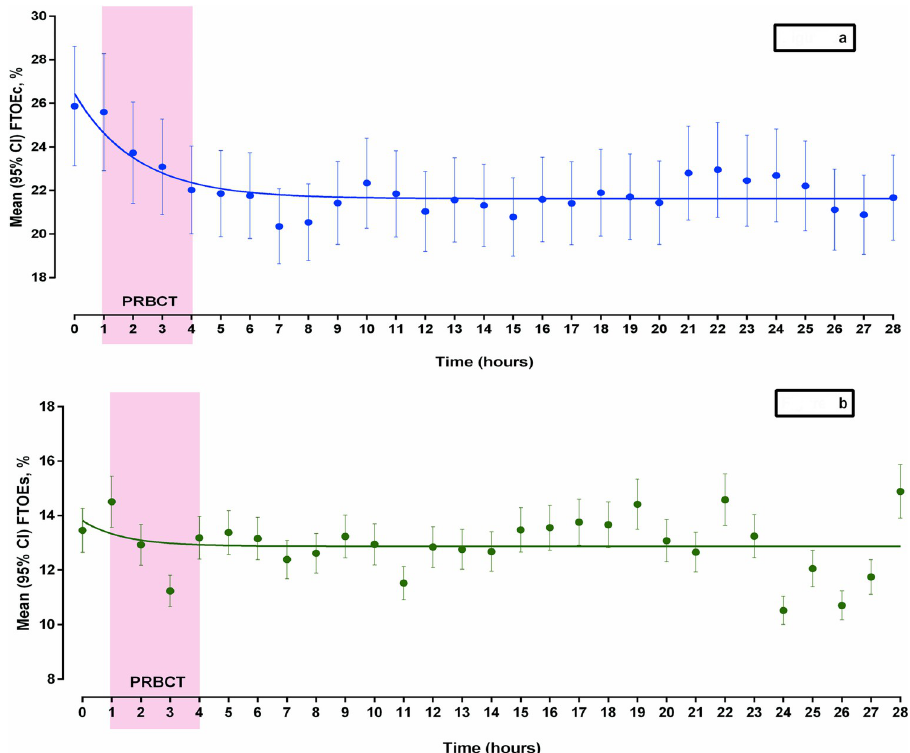
Fig 3. Transfusion-associated changes in cerebral and splanchnic Fractional Tissue Oxygen Extraction (FTOEc and FTOEs) during the study period. a: [shows mean (95% CI), and non-linear curve fit for FTOEc]: FTOEc showed a statistically significant drop following Packed Red Blood Cell Transfusion (PBRCT) and remained low, suggesting an improvement in cerebral tissue oxygenation. b: [shows mean (95% CI), and non-linear curve fit for FTOEs]: FTOEs showed fluctuations during and after Packed Red Blood Cell Transfusion (PBRCT) without any